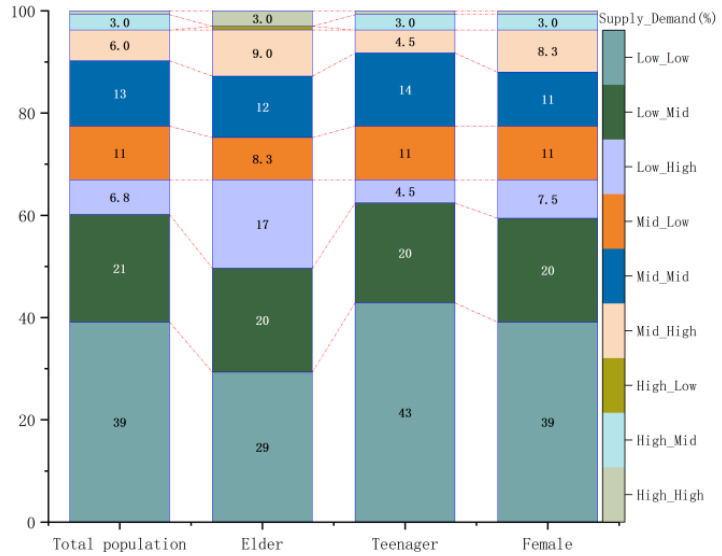
Figure 8. Statistics on the spatial match between TPS and residents’ demand.